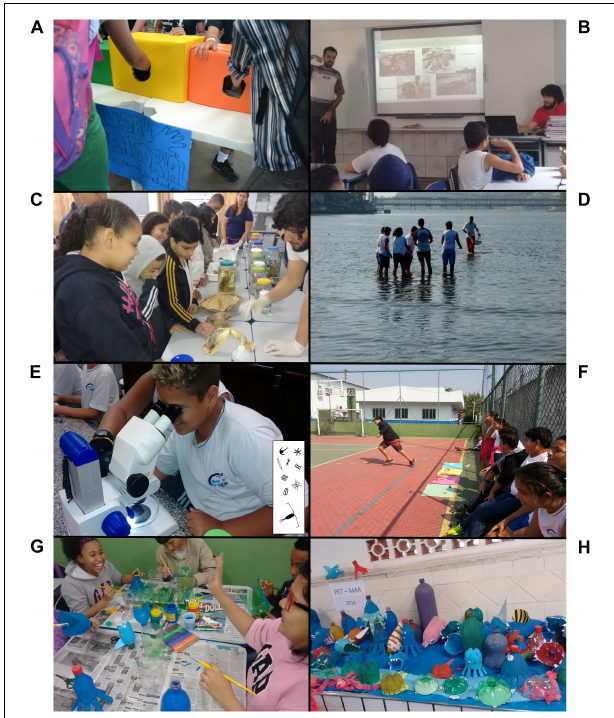
FIGURE 2 | Activities promoted by the project: (A) What is in there?; (B) Our surrounding environment; (C) Sea creatures in land!; (D,E) Understanding marine plankton (with main observed phyto- and zooplankton specimens represented inside the white rectangle); (F) Think fast and recycle!; (G,H) Our marine “pet”